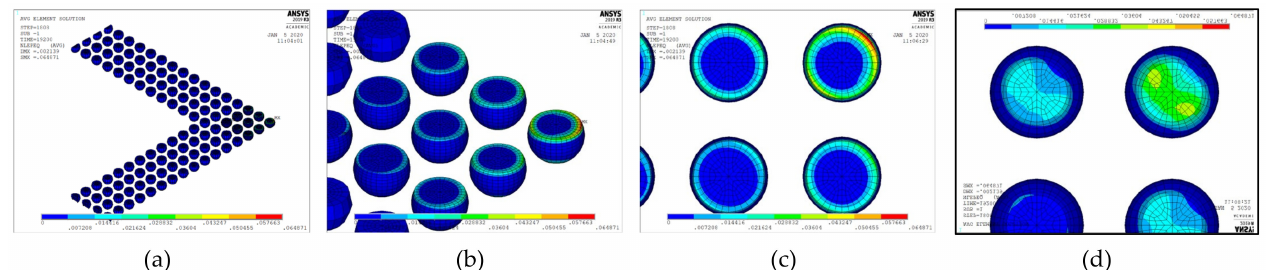
Figure 16. Equivalent inelastic strain distribution of the FO-WLP: ( a ) All solder joints; ( b ) location of the maximum strain; ( c ) top view of the bottom solder joint with the maximum distance from the neutral point (DNP); ( d ) bottom view of the solder joint with the maximum